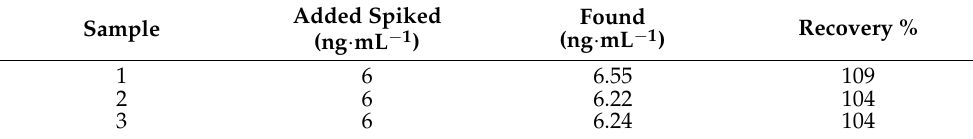
Table 3. Concentration of IgG-Ag in human serum measured by SWV.